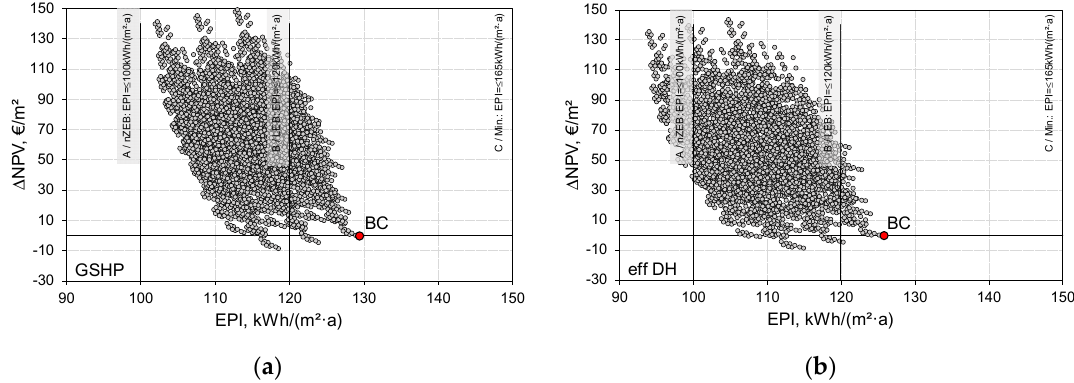
Figure 3. Energy performance indicator (EPI) and change in the net present value ( Δ NPV) for different combinations of structural solutions: ( a ) with the ground-source heat pump (GSHP); ( b ) with the efficient district heating (eff DH).